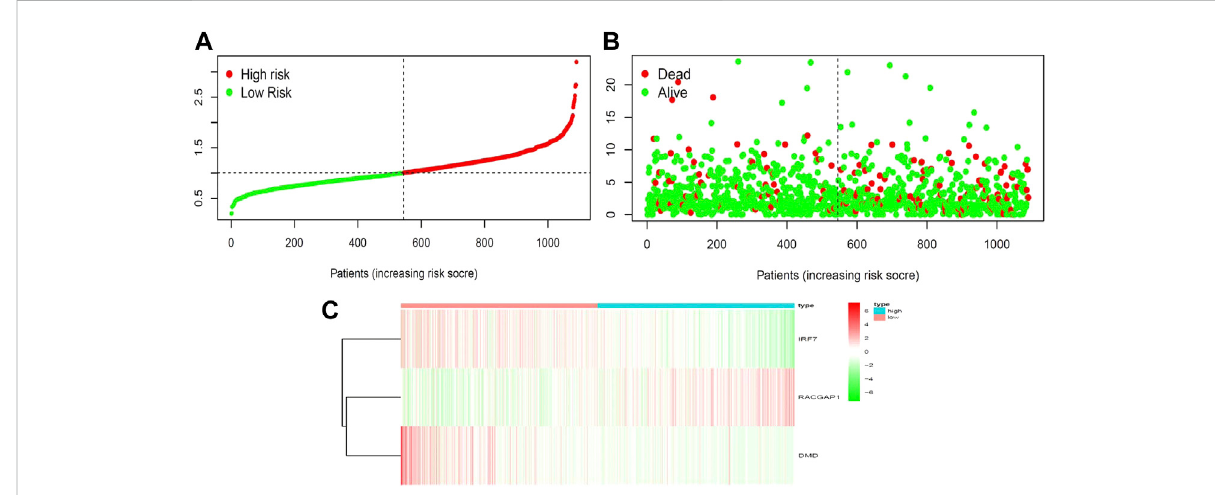
FIGURE 4 Correlationbetweensurvivalandriskscore. (A) Analysisofpatients ’ riskscoreusingCoxproportionalhazardsregression. (B) Survivinganddying patient risk score results. (C) Heatmap of core gene expression